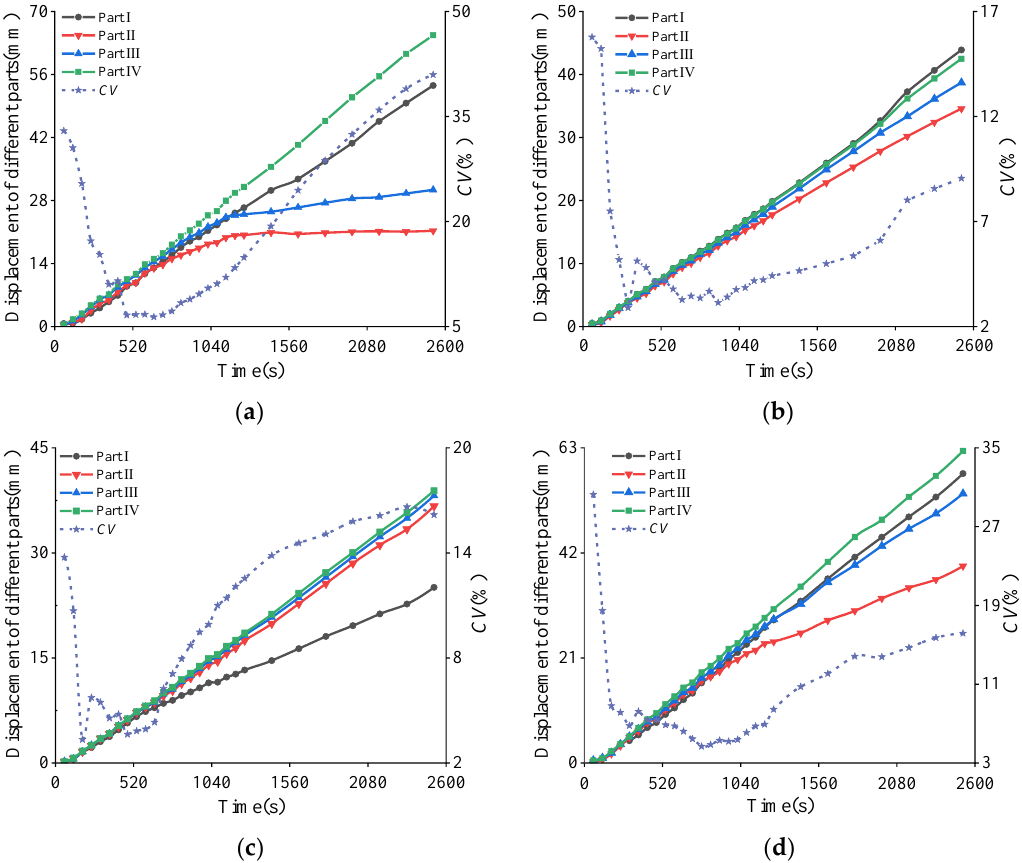
Figure 12. Displacement of different parts and coefficient of variation. ( a ) Condition 1, ( b ) condition 2, ( c ) condition 3, and ( d ) condition 4.